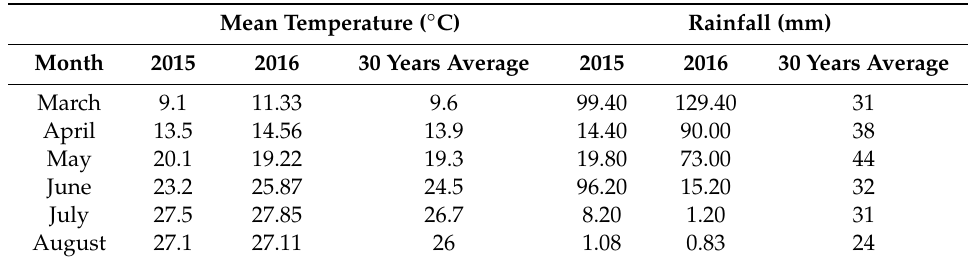
Table 1. The main weather parameters (mean temperature and rainfall) for the two growing seasons of experimentation at Thermi Greece and its comparison to the 30-year average. The weather data were recorded with an automatic weather station close to the experimental site. Mean Temperature ( ◦ C) Rainfall